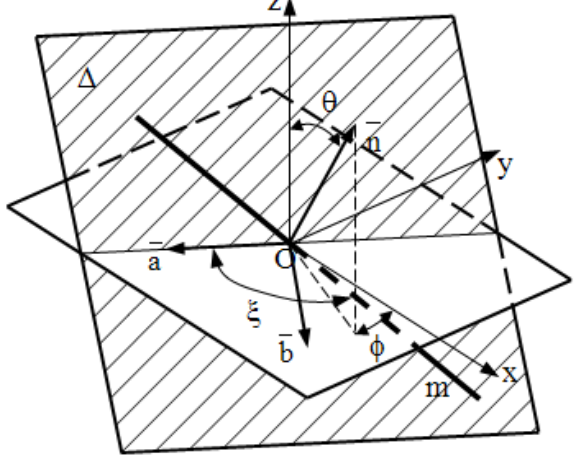
Figura 2: Definizione delle grandezze utilizzate dal